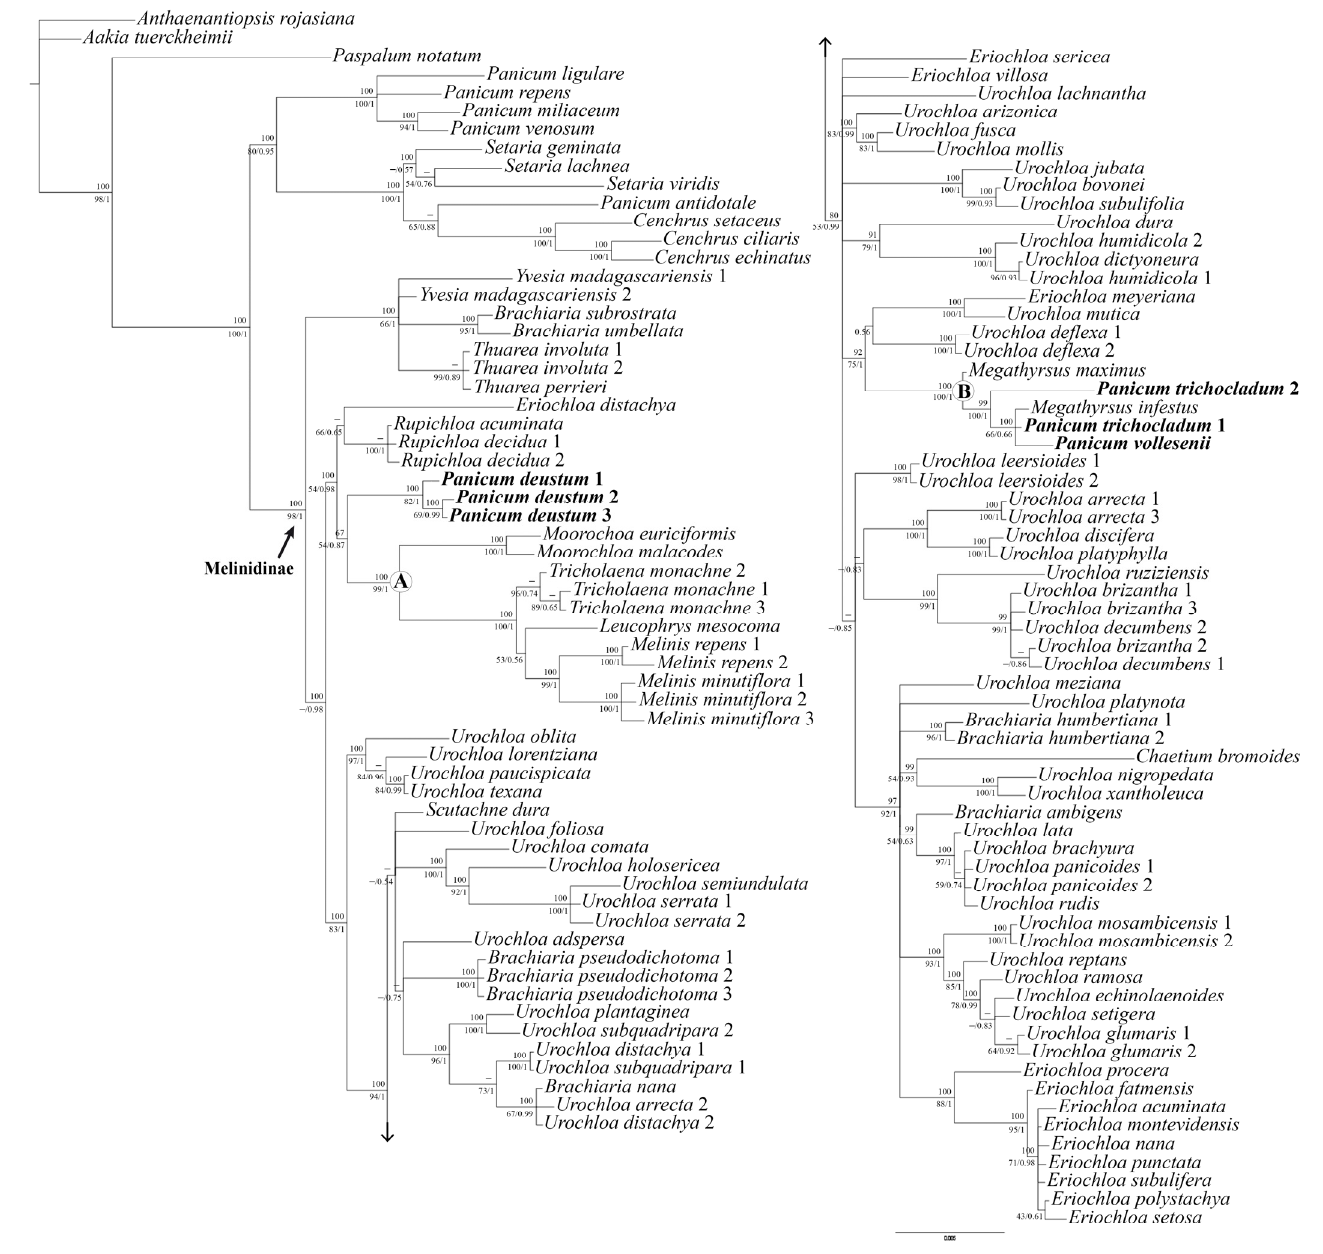
Figure 1. A 50% majority-rule consensus tree from the Bayesian inference analysis of the total combined dataset ( ndh F + rpl 16 + trn L-F). Bootstrap supports from parsimony are listed above the branches and bootstrap supports from maximum likelihood/posterior probabilities with Bayesian inference are listed below the branches. Nodes with “–” have bootstrap supports < 50%. Clades denoted by letters are discussed in the text.